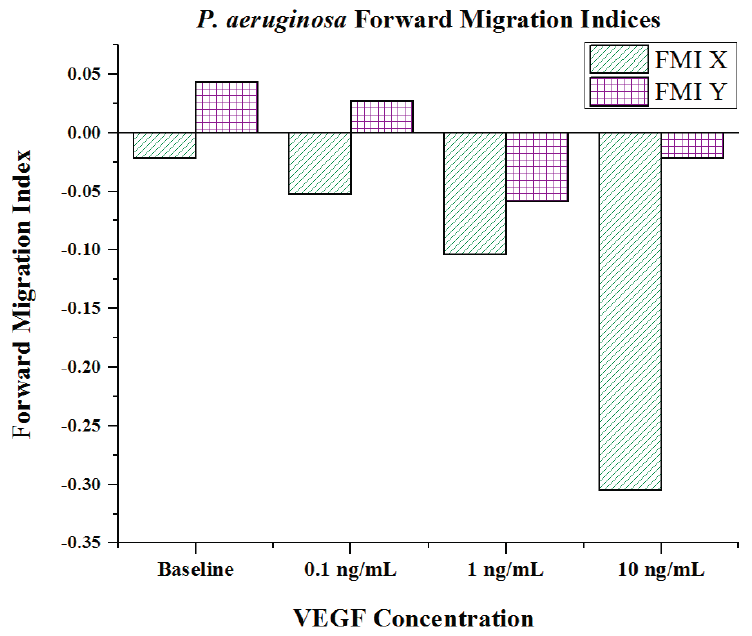
Figure 5. Forward migration indices of P. aeruginosa BK-76 cell groups in varying VEGF concentration gradients. Increasingly negative Forward Migration Index (FMI) X values indicate that cell groups more efficiently migrated along the VEGF concentration gradient (towards highest concentration). Negative values for FMI X are due to the microfluidic device orientation, as VEGF concentration gradients were generated from left (negative) to right (positive) across the chemotaxis area. Thus, migration towards the VEGF source would be shown as a negative value. ( N =